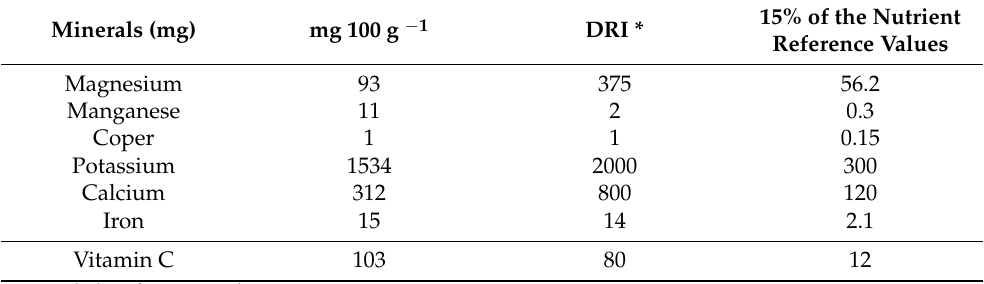
Table 3. Vitamin C and minerals in SJP and daily reference intake.